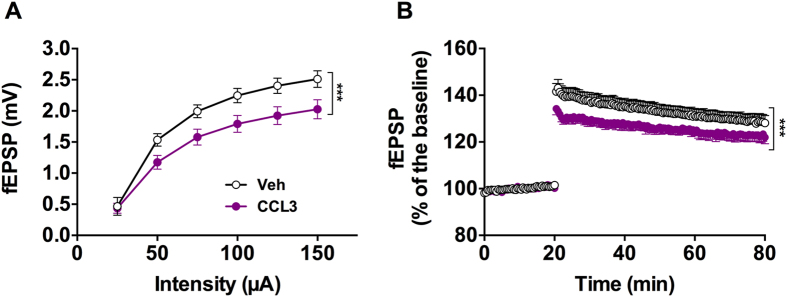
Intracerebroventricular administration of CCL3 induces impairments in hippocampal synaptic transmission and plasticity.(A) Sub-chronic i.c.v administration of CCL3 impairs hippocampal input-output curve (n = 5–6/group, ***p < 0.001 vs. Vehicle-injected mice, TWO-Way ANOVA). (B) Sub-chronic i.c.v administration of CCL3 induces a significant decrease of the LTP after the induction by 4 trains at high frequency (n = 5–6/group, ***p < 0.001 vs. Vehicle-injected mice, TWO-Way ANOVA). In order to normalize the pre-LTP signal between different conditions, an I/V curve was realized before baseline recording to adjust the intensity of the stimulus of each experiment to elicit a fEPSP of 35% of the maximum. This intensity was kept constant throughout the protocol.